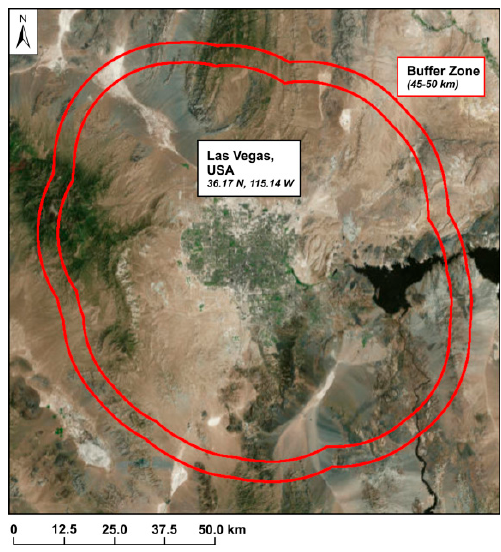
Figure 3. An example buffer created around Las Vegas, NV, USA.